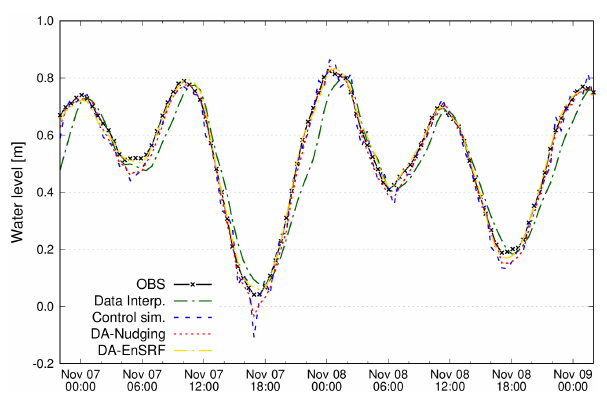
Figure 4. Observed, interpolated, and simulated water levels at sta- tion 12. In this computation, station 12 was not included in the DI and DA algorithms.